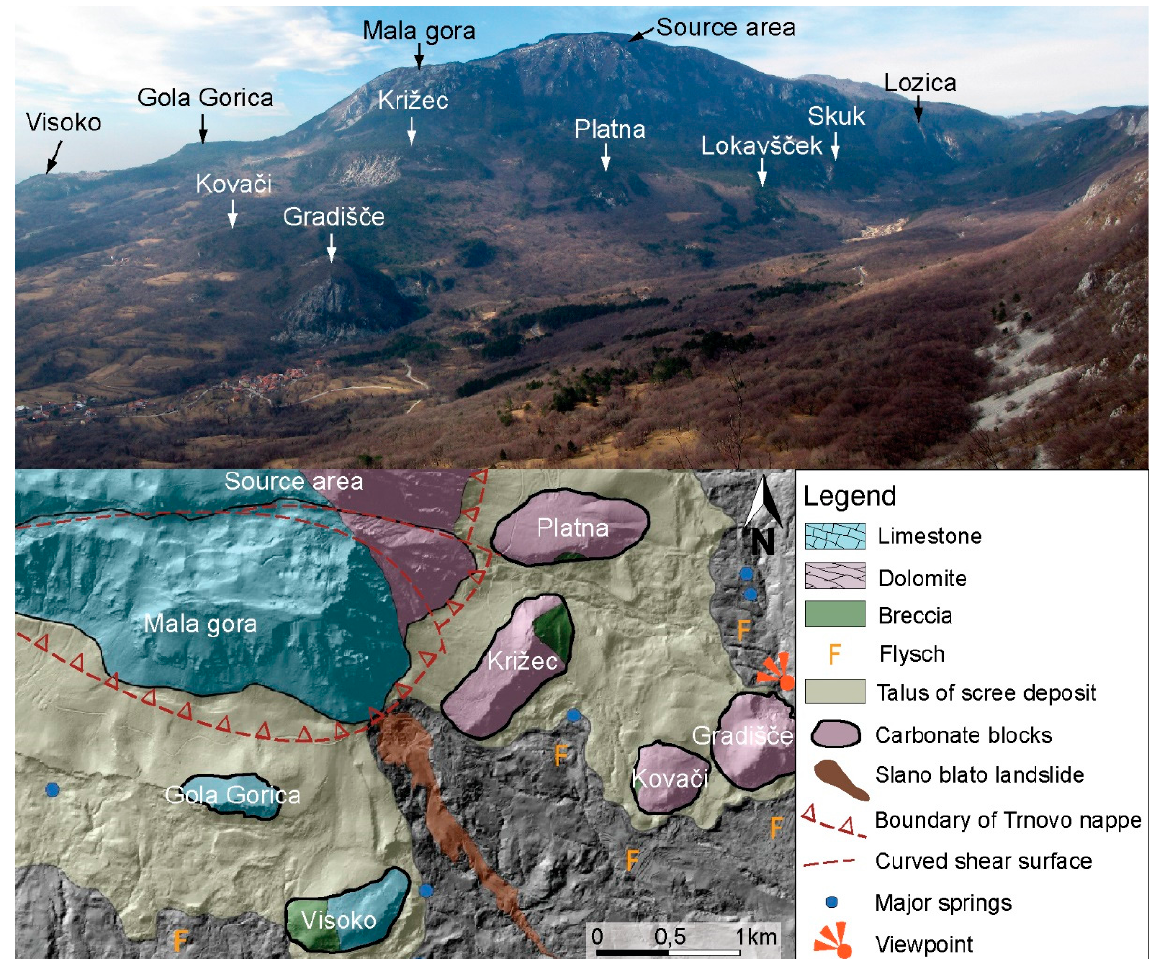
Figure 2. Photograph of carbonate gravitational blocks (upper figure) from Navrše hill (view towards W) and lithology of the wider source area and carbonate blocks (lower figure). Adapted and modified after [18]. Reprinted and adapted with permission from Ref. [18]. Copyright 2019, Založba